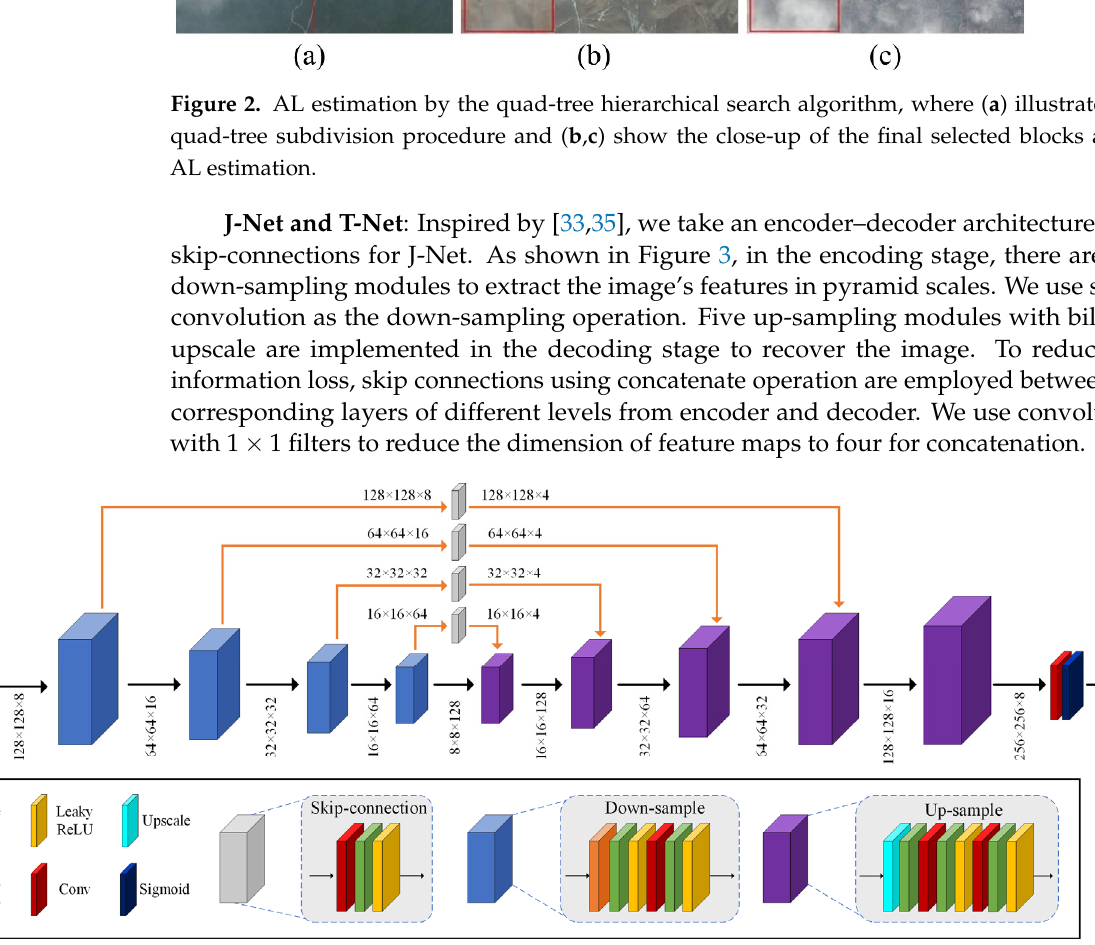
Figure 3. The network architecture of the J-Net.